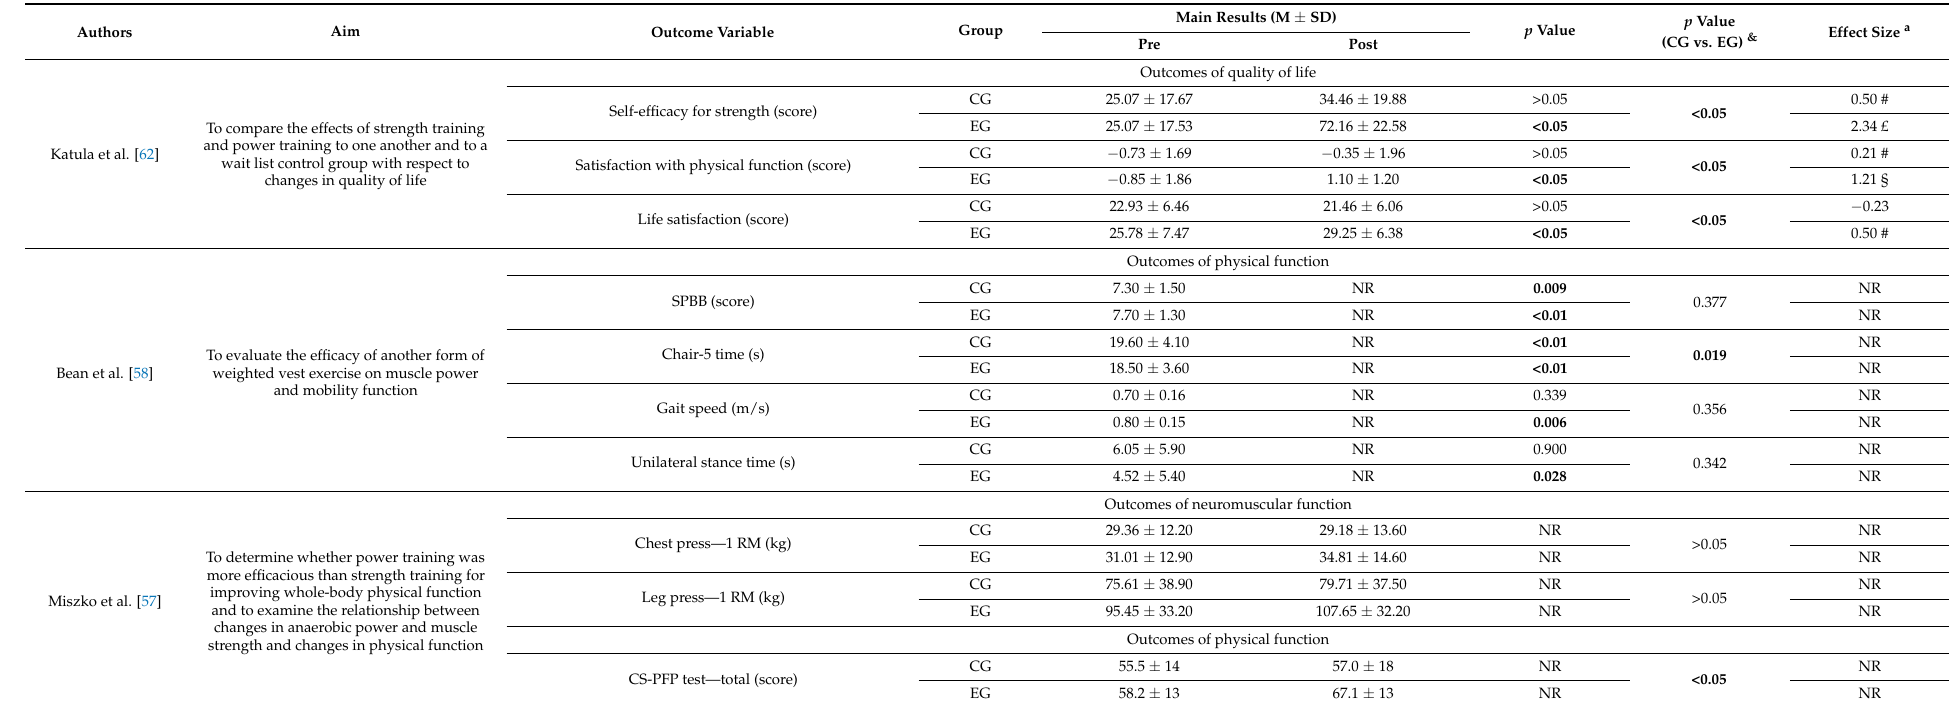
Abbreviations: Significant differences are highlighted in bold. CG, control group; EG, experimental group; M, mean; SD; standard deviation; NR, not reported; MMSE, mini-mental state test; FAB, frontal assessment battery; SPPB, short physical performance battery; TUG, time up and go test; ms, milliseconds; s, seconds; kg, kilograms; BW, body weight; Nm,